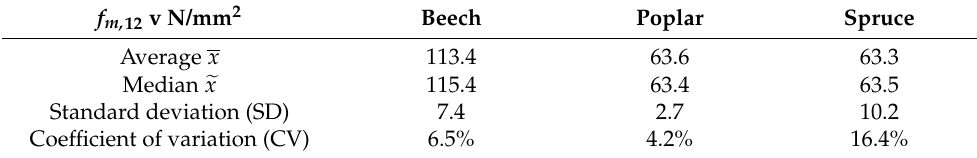
Table 2. Experimentally measured bending strength of the lamellae.